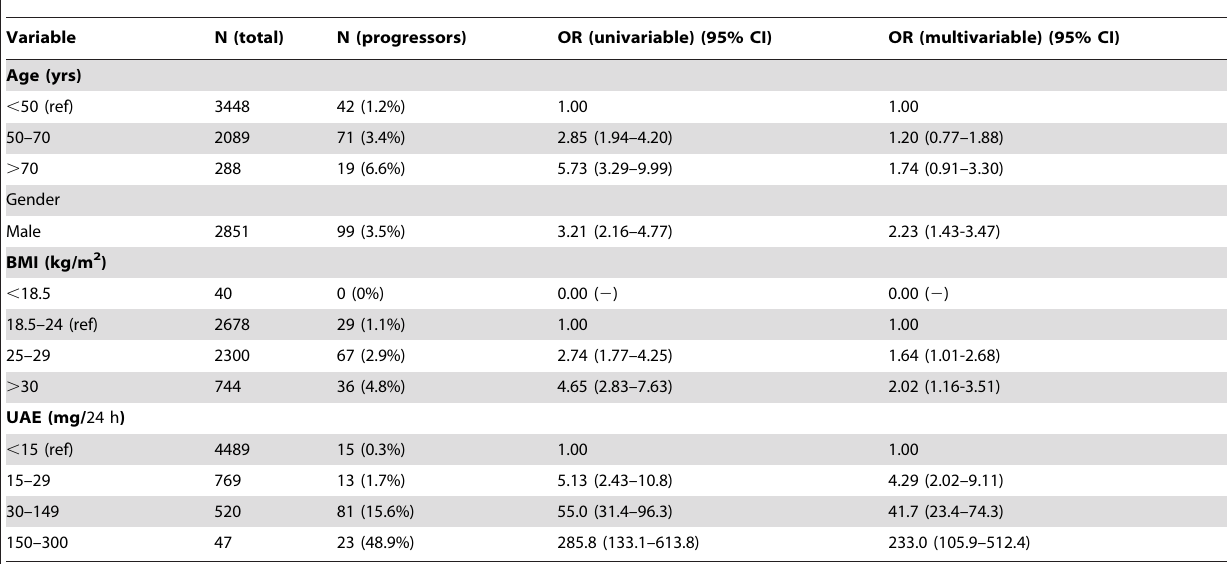
Table 4. Results of the univariable and multivariable logistic regression analyses for progressive albuminuria.